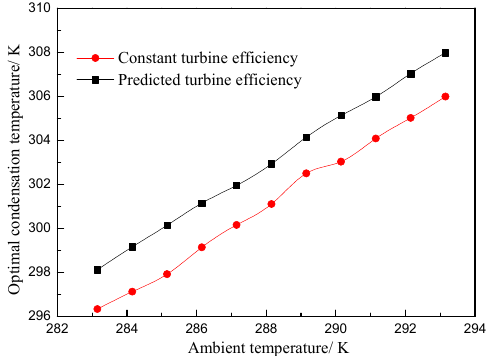
Figure 16. Optimal condensation temperature at different ambient